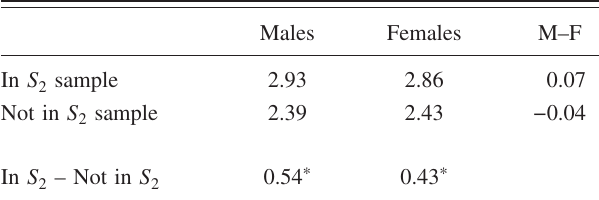
second regression sample (cid:1) S 2 (cid:2) and those who are not in the S 2 sample. Course grades are on a 0.0 to 4.0 scale. The asterisk (cid:1) (cid:1) (cid:2) indicates that the differences are significant (cid:1) p (cid:1) 0.05 (cid:2)